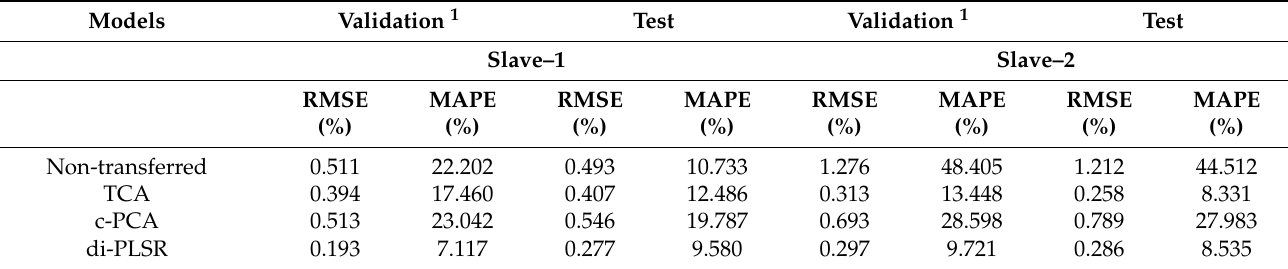
Table 2. Evaluation of nitrogen predictions obtained via TCA, c-PCA, and di-PLSR with reference to the master predictions.